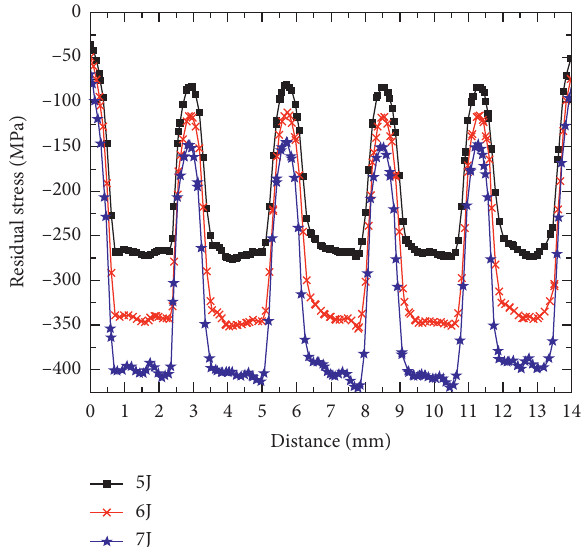
Figure 7: Curves of residual stress distribution of sample surface with different laser